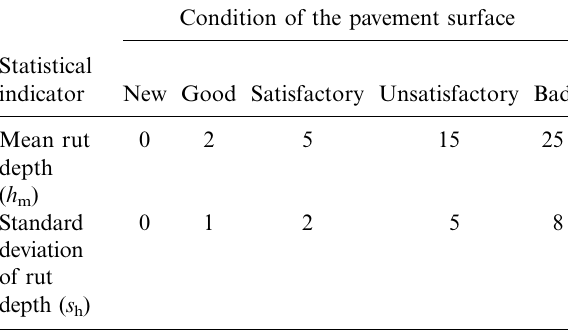
Table 1. Permissible parameters of rut depth (mm)